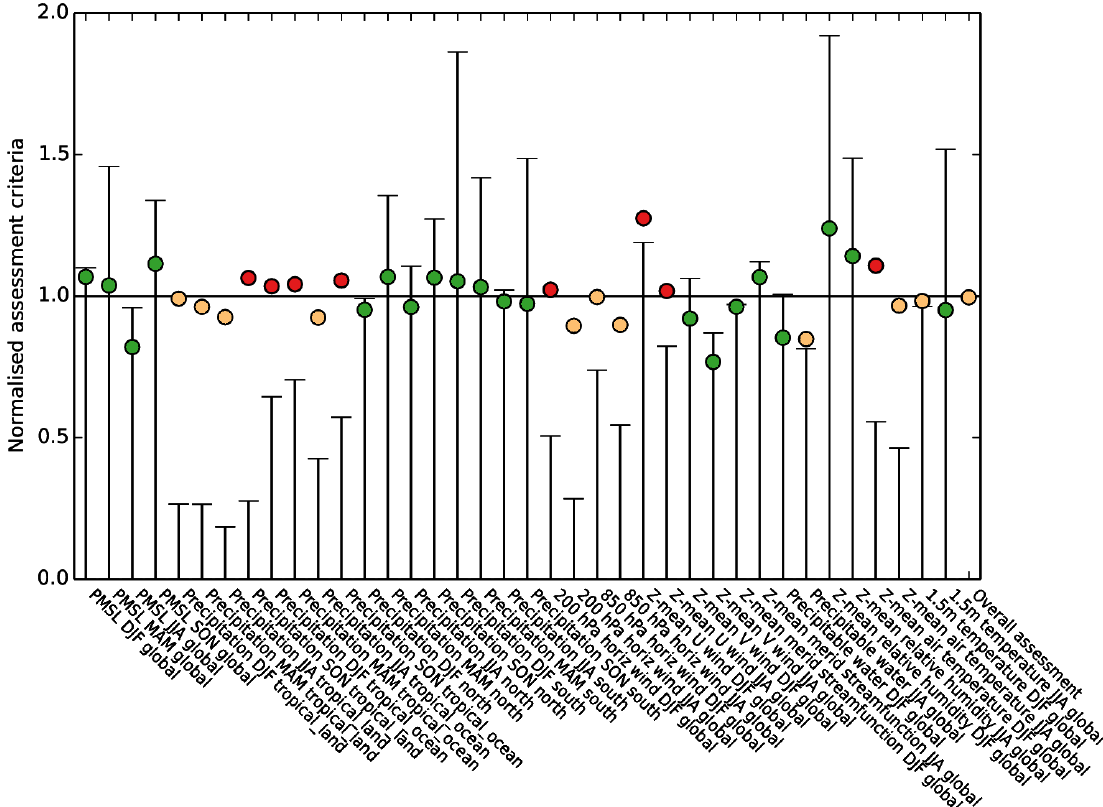
Figure 12. Normalised assessment criteria (ratio of mean field RMSEs) for a number of atmospheric fields from a GA7.0/GL7.0 atmosphere/land-only climate simulation at N216 horizontal resolution compared to an equivalent simulation using GA6.0/GL6.0. Statis- tics shown are for seasons DJF, MAM, JJA and September–November (SON) and for global, tropical land (land points between 30 ◦ N and 30 ◦ S), tropical ocean (sea points between 30 ◦ N and 30 ◦ S), north (30–90 ◦ N) and south (30–90 ◦ S) regions. The observation datasets used are HadSLP2 pressure at mean sea level (Allan and Ansell, 2006), GPCP precipitation (Adler et al., 2003), SSMI precipitable water (Wentz and Spencer, 1998) and CRUTEM3 1.5m temperature (Brohan et al., 2006), whilst the remaining climatologies are from ERA-Interim re- analyses (Berrisford et al., 2009). The whisker bars are observational uncertainty, which is calculated by comparing these with alternative datasets; these are ERA-40 pressure at mean sea level and precipitable water (Uppala et al., 2005), CMAP precipitation (Xie and Arkin, 1997), Legates and Willmott (1990a) 1.5m temperature and MERRA reanalyses for everything else (Bosilovich, 2008). Green circles denote fields for which the RMSE lies within observational uncertainty, whilst light orange or red circles denote fields for which the RMSE is not within observational uncertainty and for which the RMSE is improved or degraded